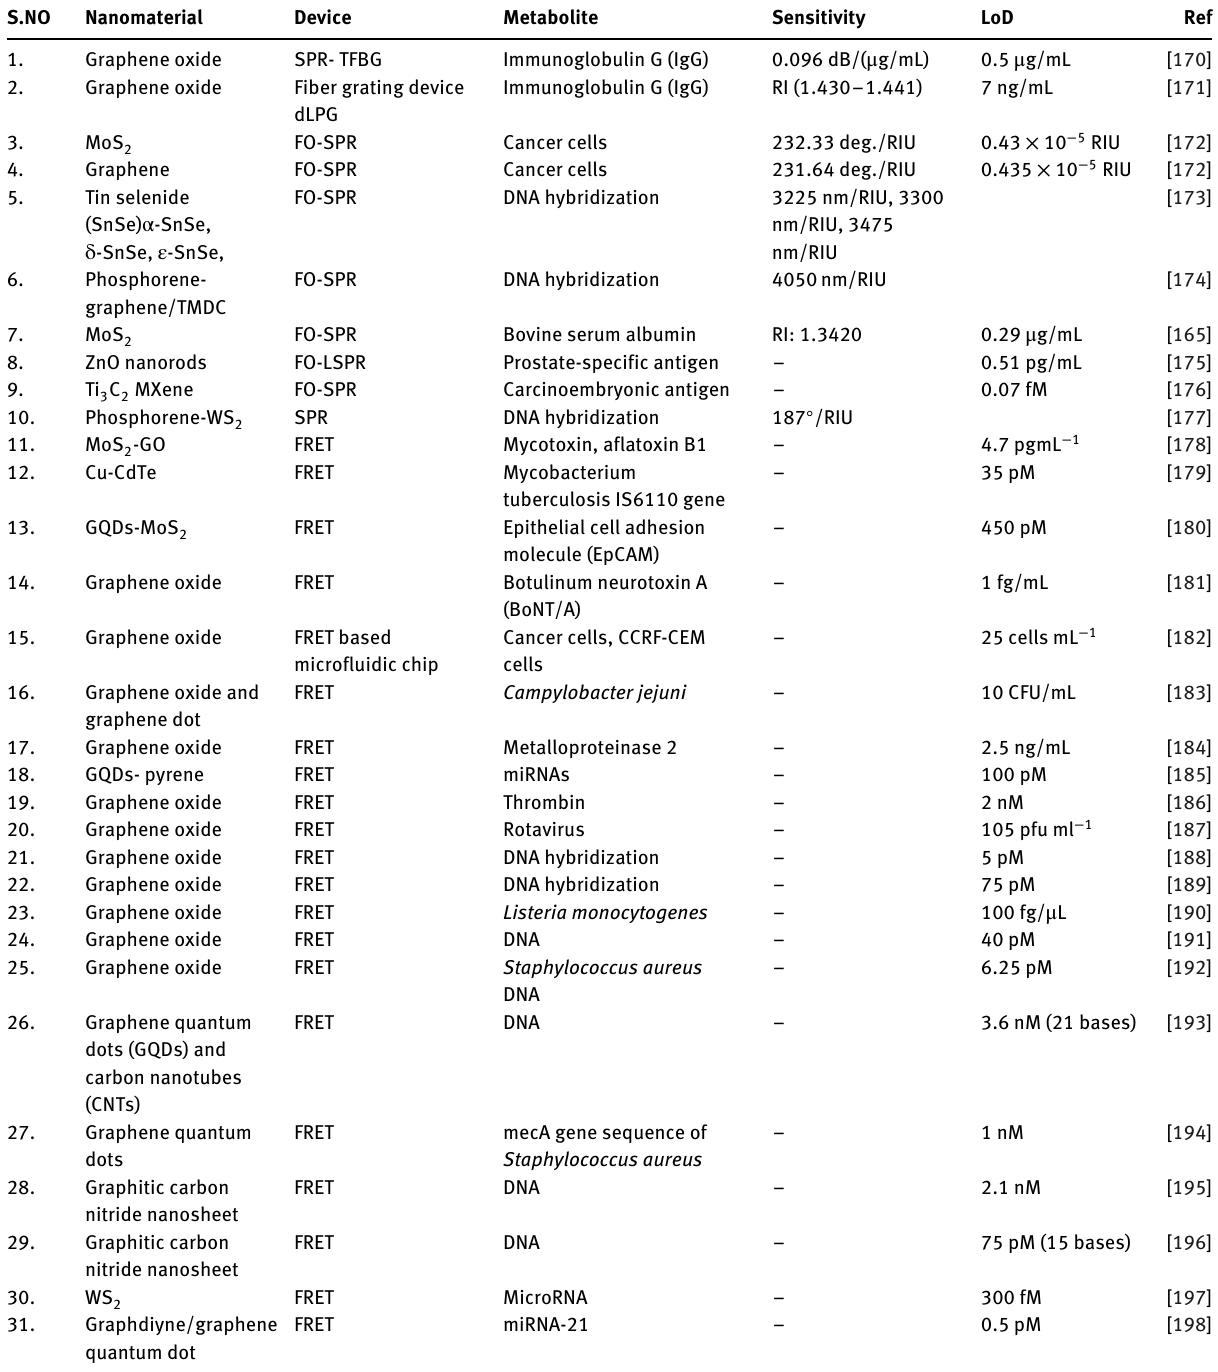
Table 2: 2D materials for photonics based omics